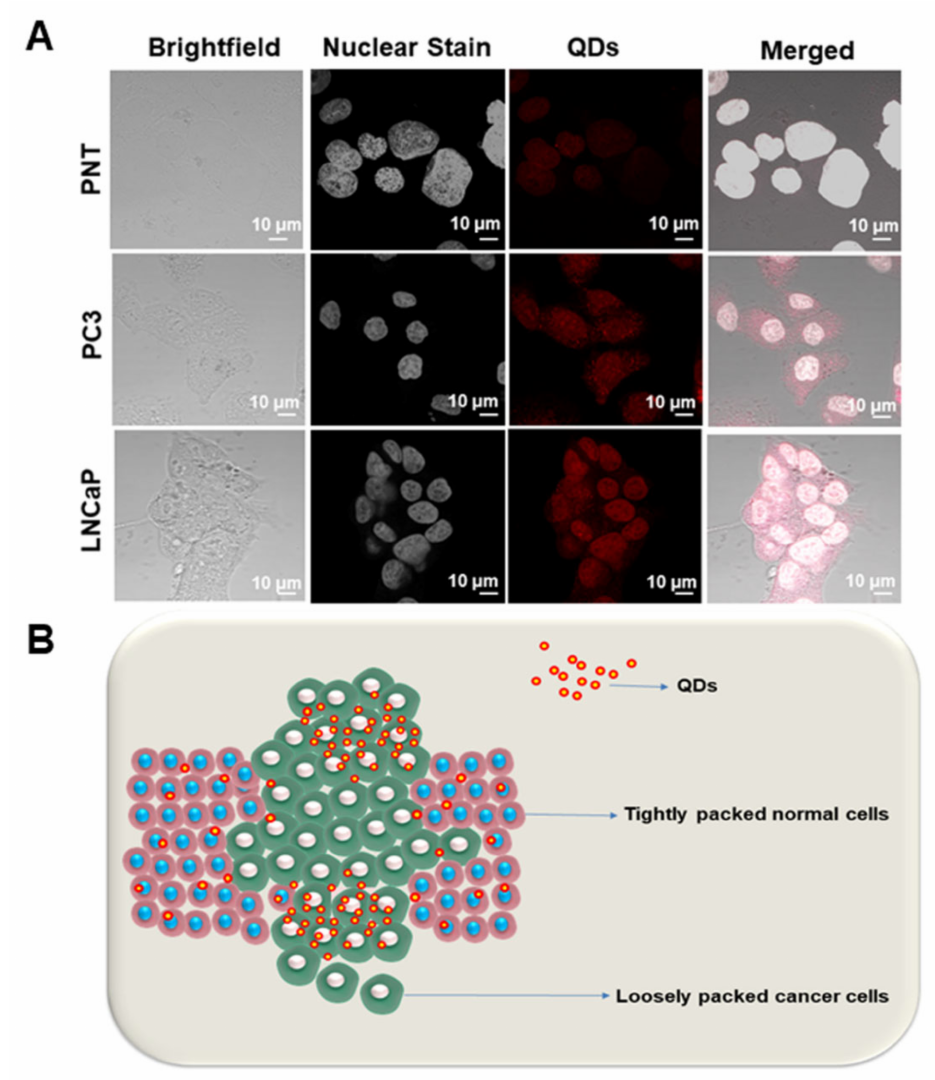
Figure 6. ( A ) Confocal microscopy images showing the uptake of AgInSe/ZnS QDs in prostate normal cells (PNT), prostate cancer cells (PC3), and human prostate adenocarcinoma cells (LNCaP). ( B ) Possible mechanism for the differential uptake of QDs in cancer and normal